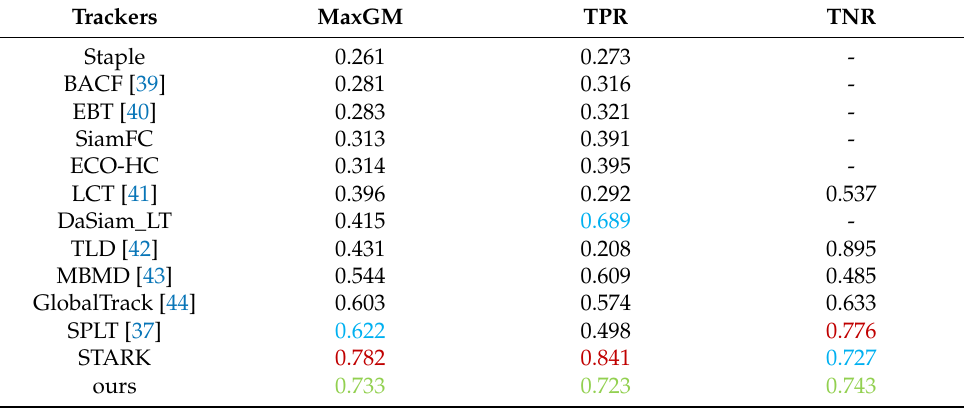
Table 7. Comparisons on the Ox-UvA [33] long-term dataset. The best three results are marked in red, green, and blue bold fonts,